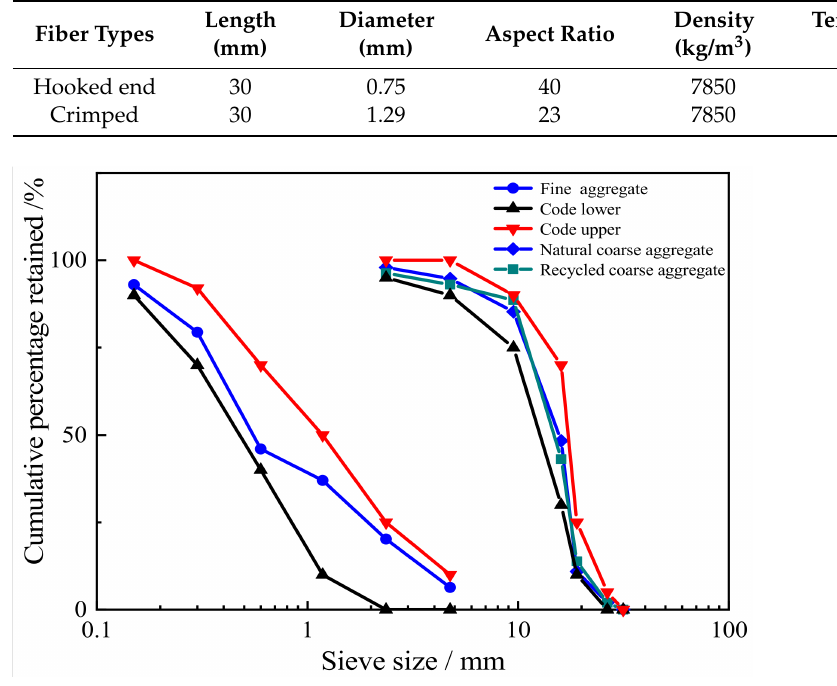
Figure 2. Gradation curves of